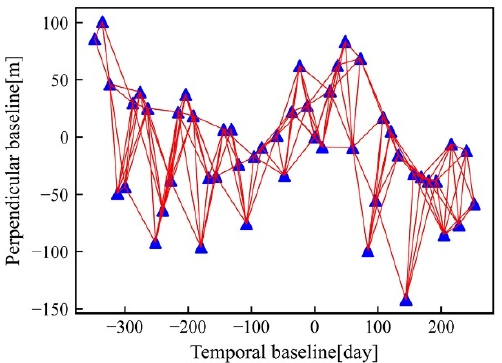
Figure 12. Temporal and perpendicular baselines of Sentinel-1 data.